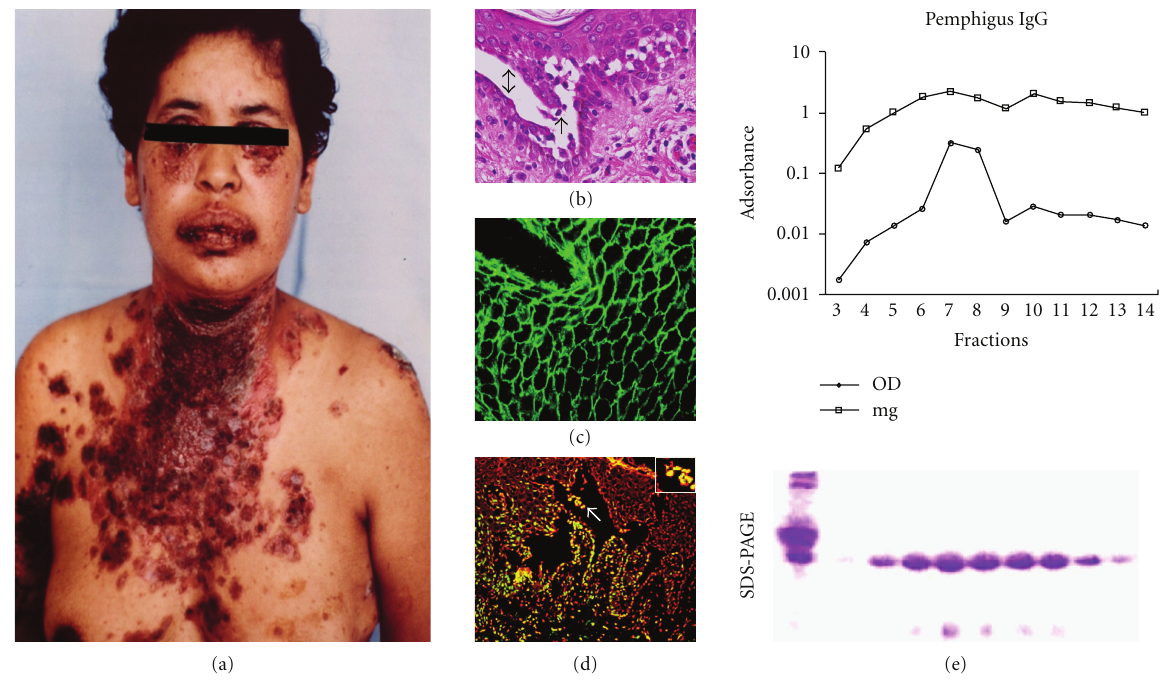
Figure 1: (a) Patient with pemphigus vulgaris showing extensive blistering in trunk and mouth. (b) Skin biopsy stained with H&E showing intraepidermal blister (double arrow) and acantholytic cells (arrow). (c) Patient sera showed antiepithelial antibodies using indirect immunofluorescence. (d) Intraepidermal blister showing that apoptotic cells (green) detected using TUNEL and counterstained with propidium iodide were present in the lesional area (square). (e) Isolation of pemphigus IgG using a ffi nity chromatography. The chromatogram shows that the IgG peak was in fractions 7–9. OD: optical density. The bottom panel shows an SDS-PAGE gel of the eluted fractions.